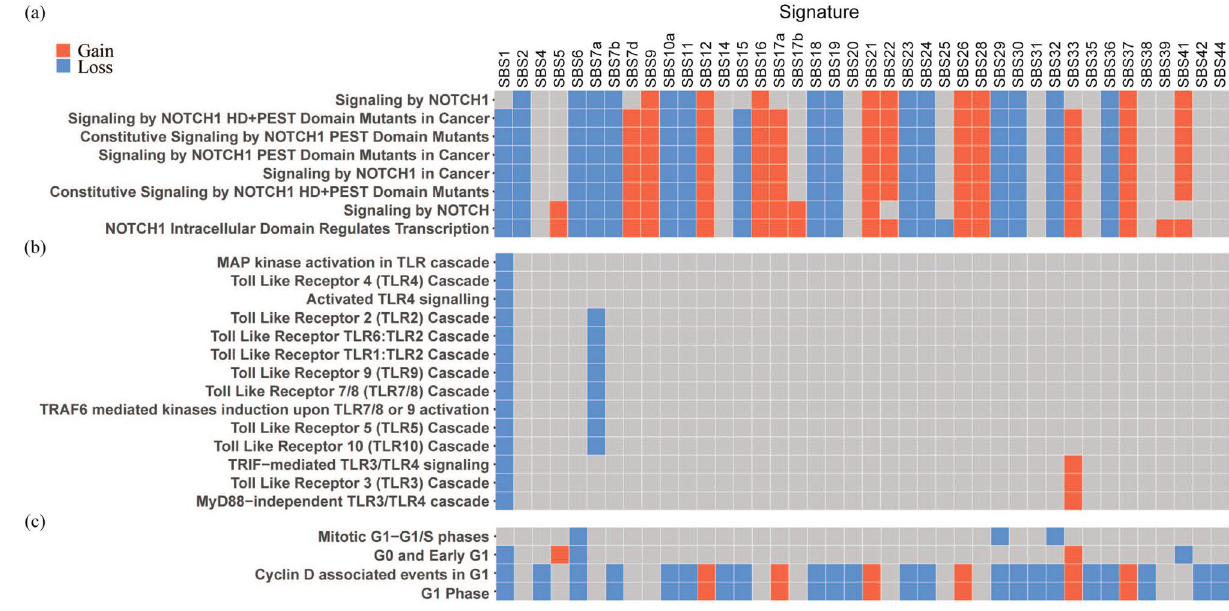
Figure 5. Signatures with pathways enriched for gain or loss-of-binding TFs. ( a ) NOTCH1 pathways. ( b ) TLR (toll-like receptor) signaling pathways. ( c ) G0-G1-S phase